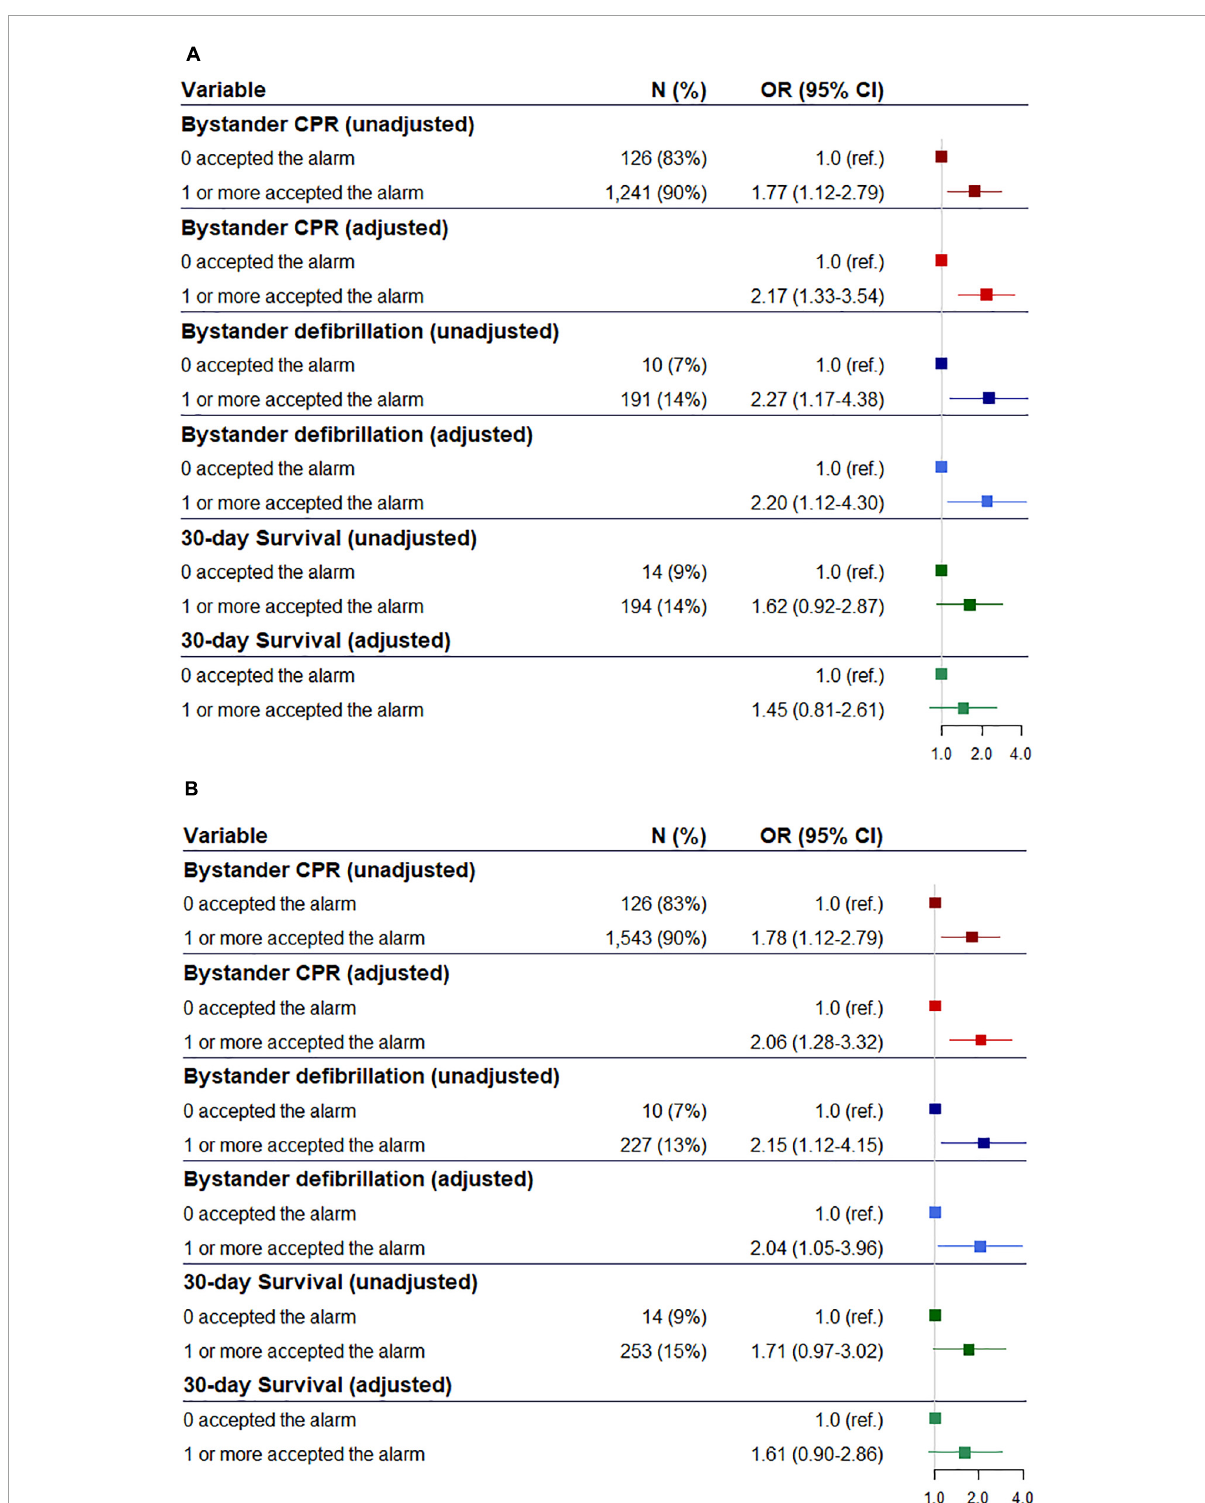
FIGURE3 (A) Odds ratio and adjusted odds ratio of association between arrival at out-of-hospital cardiac arrest (OHCA) site of volunteer responder and bystander cardiopulmonary resuscitation and bystander defibrillation with alarm not accepted as reference. (B) Odds ratio and adjusted odds ratio of association between alarm acceptance and bystander cardiopulmonary, bystander defibrillation and 30-day survival with alarm not accepted as